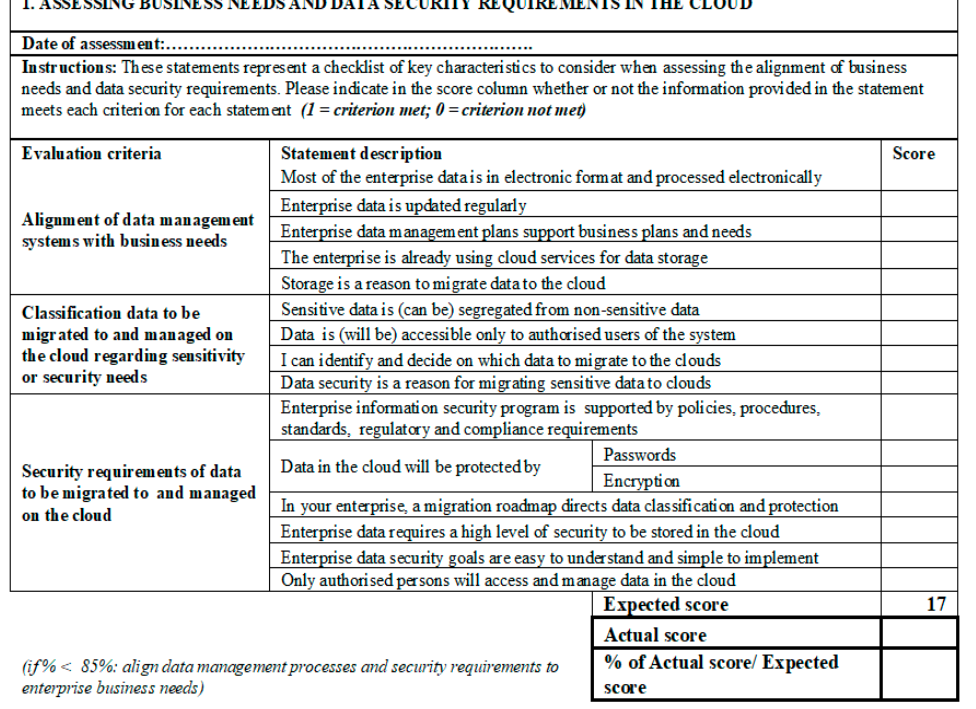
Figure 8. Checklist for assessing business needs and enterprise data security requirements.